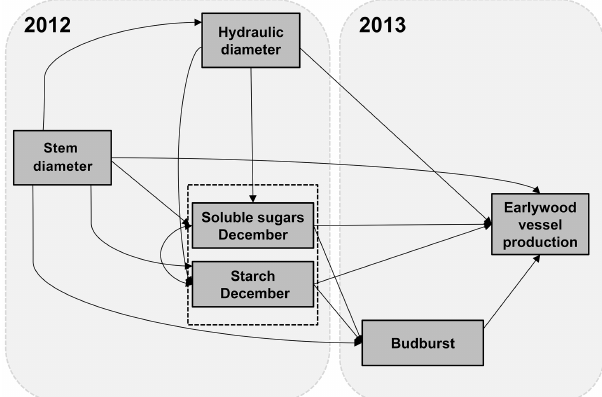
Figure 2. Structure of the hypothetical conceptual model showing interactions among stem diameter, hydraulic diameter in 2012, sol- uble sugars and starch concentrations in December 2012, and bud- burst date and earlywood vessel production in